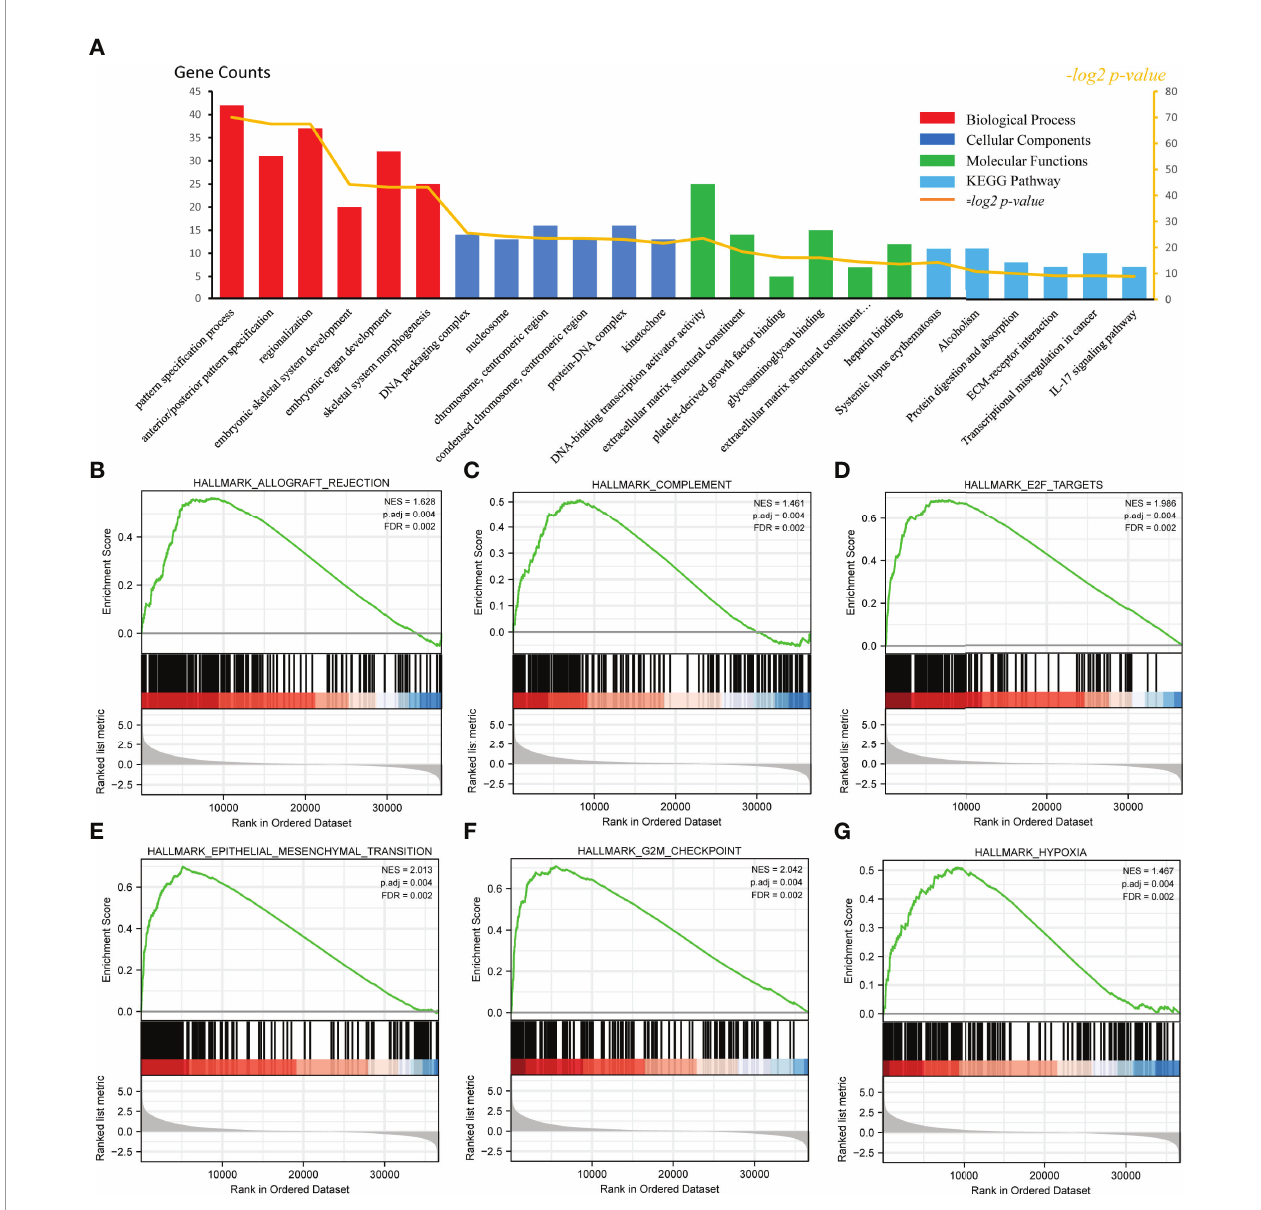
FIGURE 5 | Functional enrichment analysis of CKS2 in glioma. (A) Differentially expressed genes (DEGs) were classi fi ed as belonging to BP, CC, or MF classes. Gene set enrichment analysis (GSEA) was used to identify enriched gene classes associated with (B) allograft rejection, (C) complement, (D) E2F targets, (E) epithelial – mesenchymal transition, (F) G2M checkpoint, and (G)